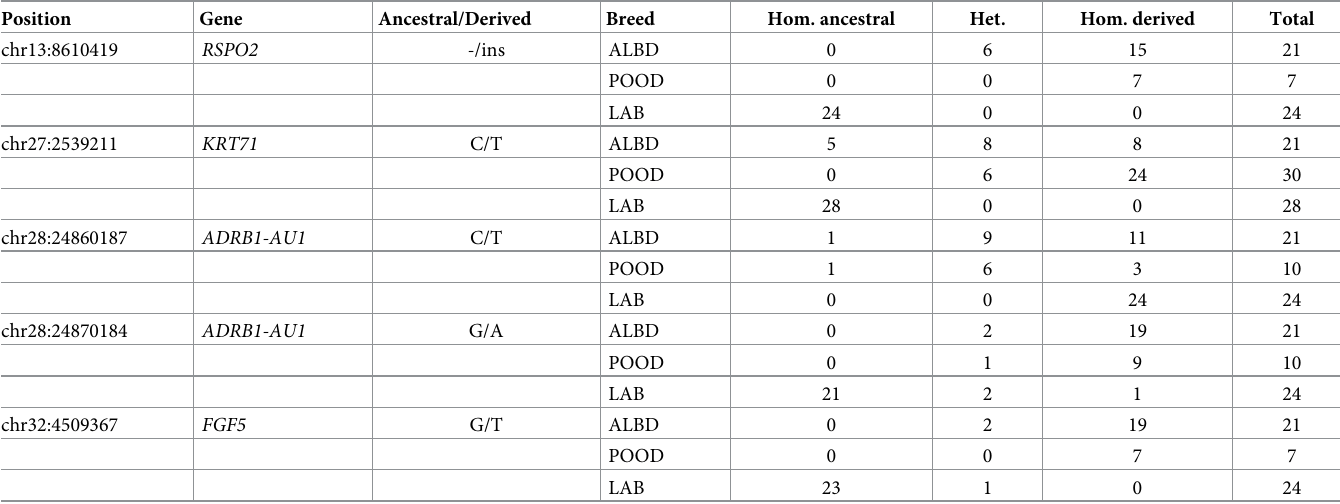
Table 3. Genotyping results for coat variants in ALBD, POOD, and LAB. Position